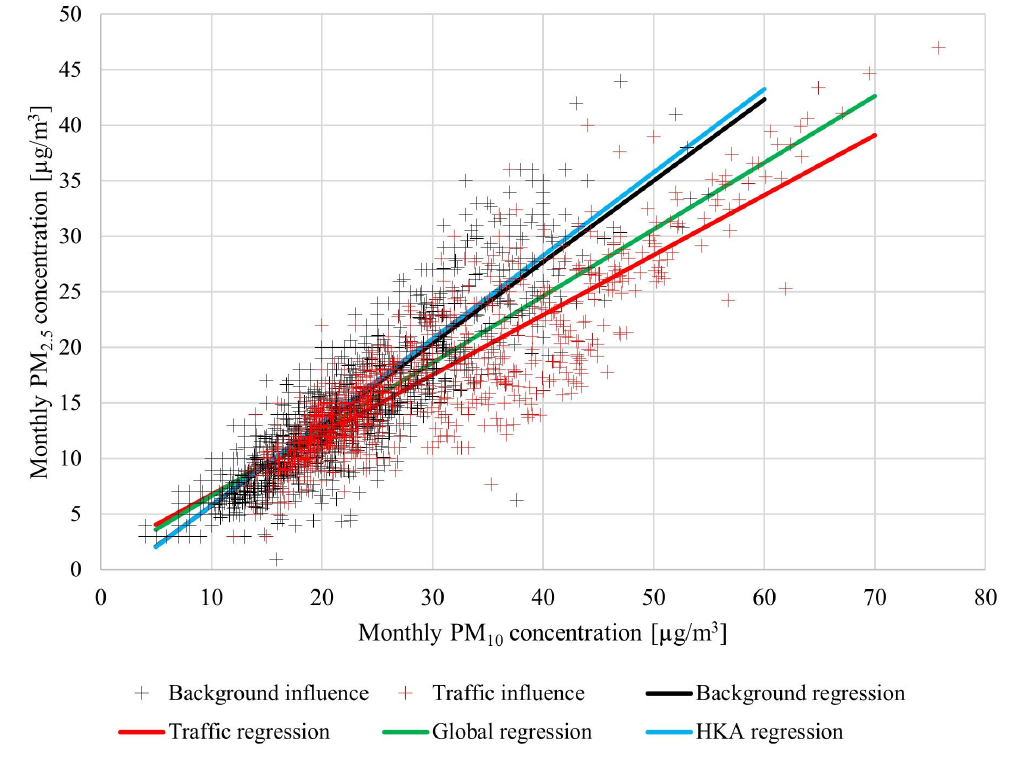
Figure 9. Monthly concentration of PM 2.5 against monthly concentration of PM 10 .